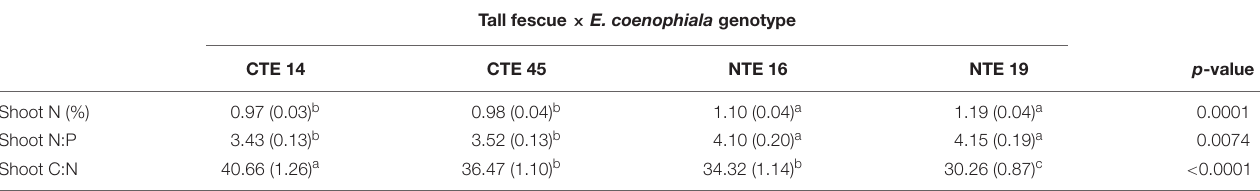
TABLE 2 | Main effect of tall fescue symbiotic genotype on plant nutrient characteristics in tall fescue tissue, where there were no interactions with endophyte status or precipitation.